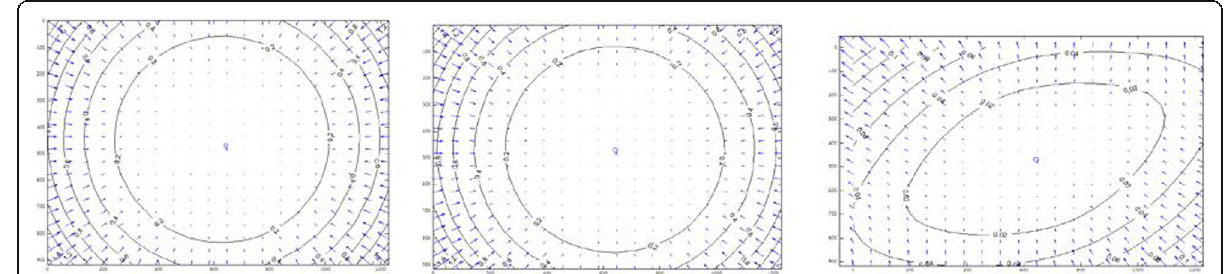
Fig. 5 Optimization residual for different search